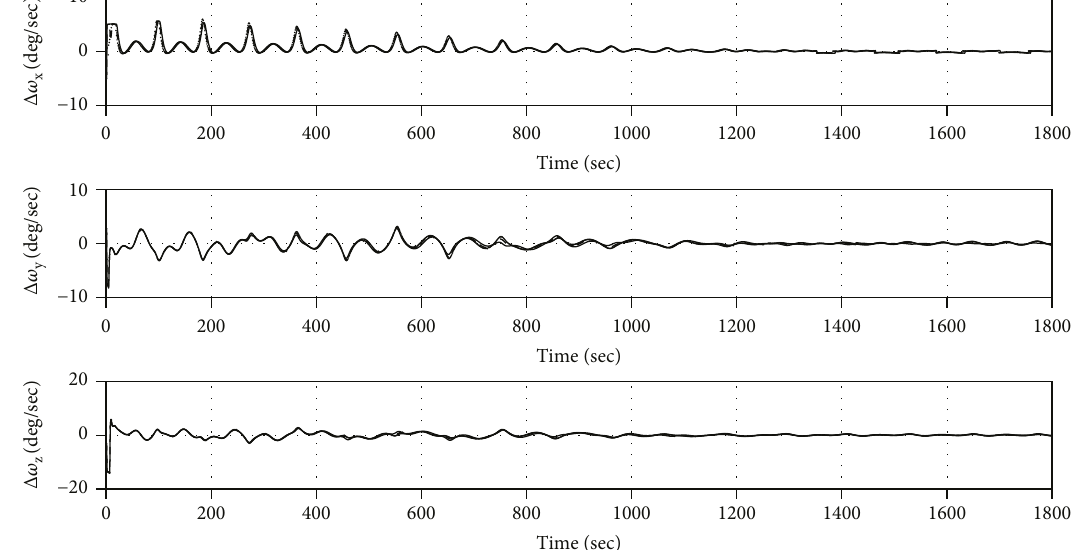
Figure 12: Measurement errors for exact [ J ] (solid line), 10% error on J